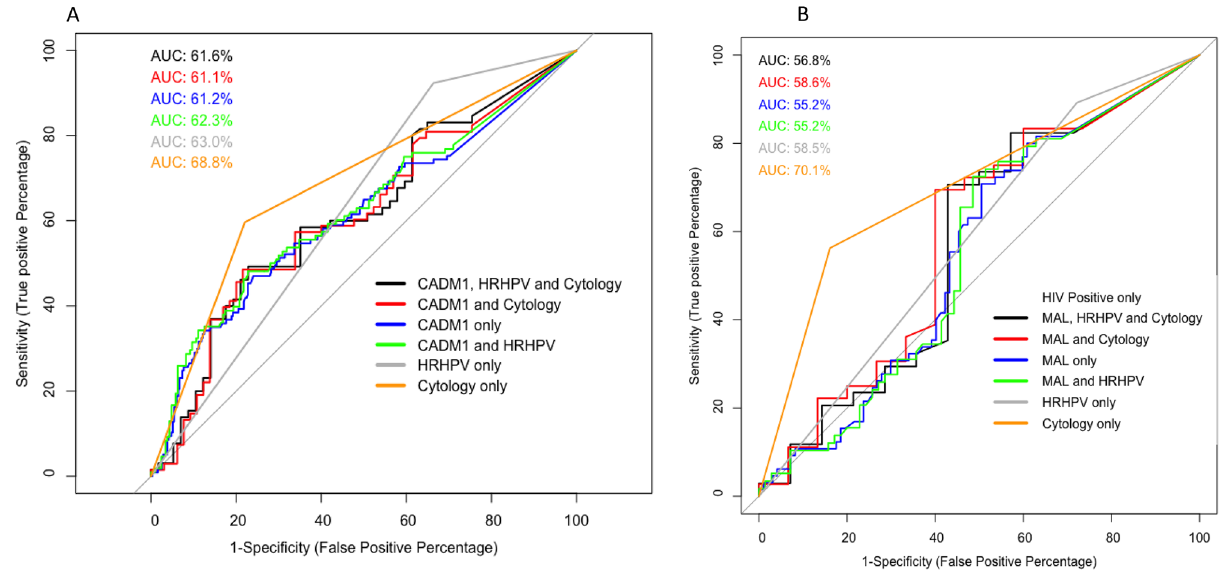
Figure 6. Difference in predictive power for different screening algorithms for anal cancer in men to identify histology defined HSIL from LSIL and normal combined. Algorithms include combinations of gene methylation and/or HRHPV positivity and/or cytology defined HSIL for ( A ) gene CADM1 in all men and ( B ) gene MAL in HIV positive men only. Comparisons for each gene are identical and include gene methylation in men with HRHPV and HSIL cytology (black), gene methylation in men with HSIL cytology (red), gene methylation only (blue), gene methylation in men with HRHPV (green), HRHPV positivity only (grey) and cytology defined HSIL only